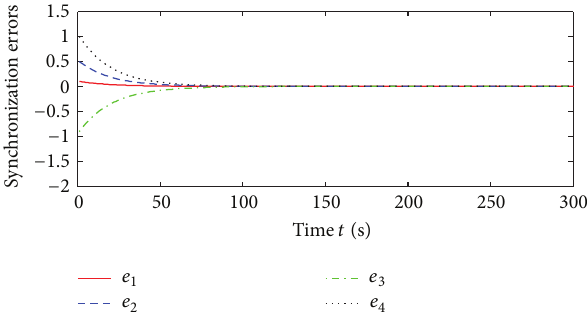
Figure 1: Synchronization errors between Chen